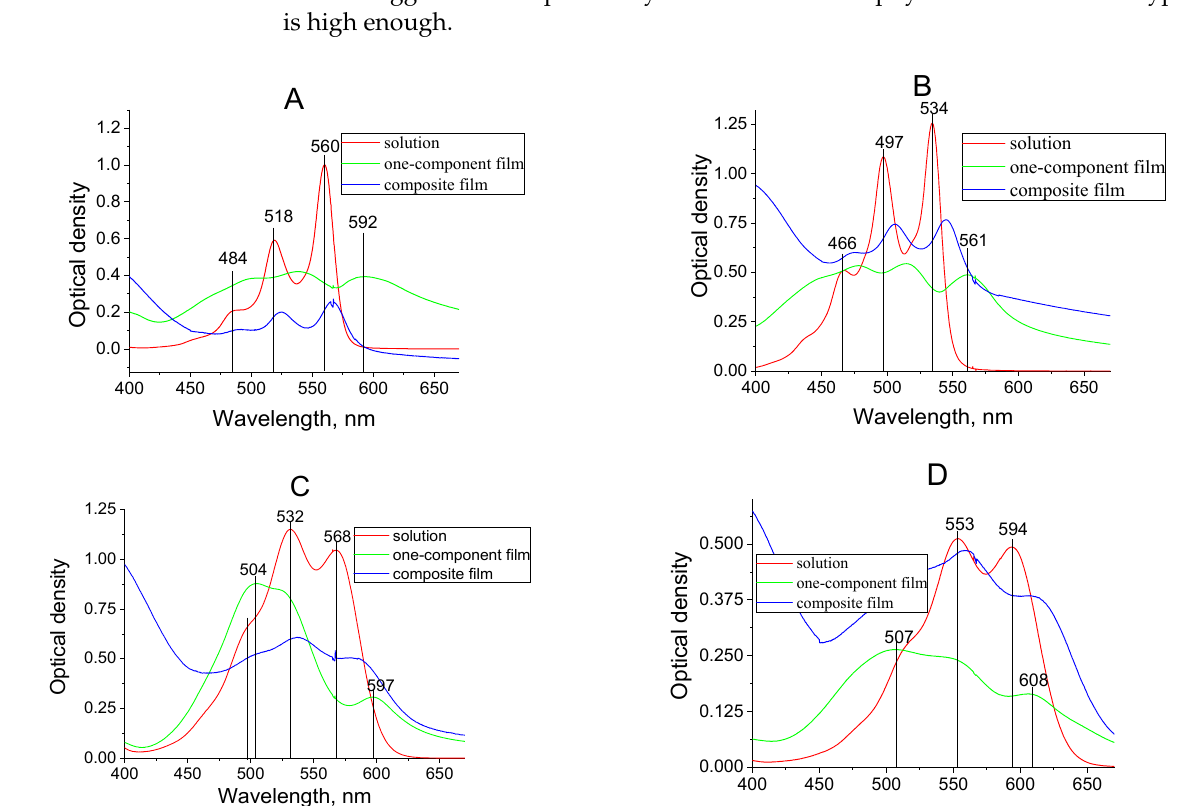
Figure 9. Absorption spectra of one-component, composite “Alq 3 +dye” films and tetrahydrofuran solutions of dyes I ( A ), II ( B ), III ( C ), IV ( D ).